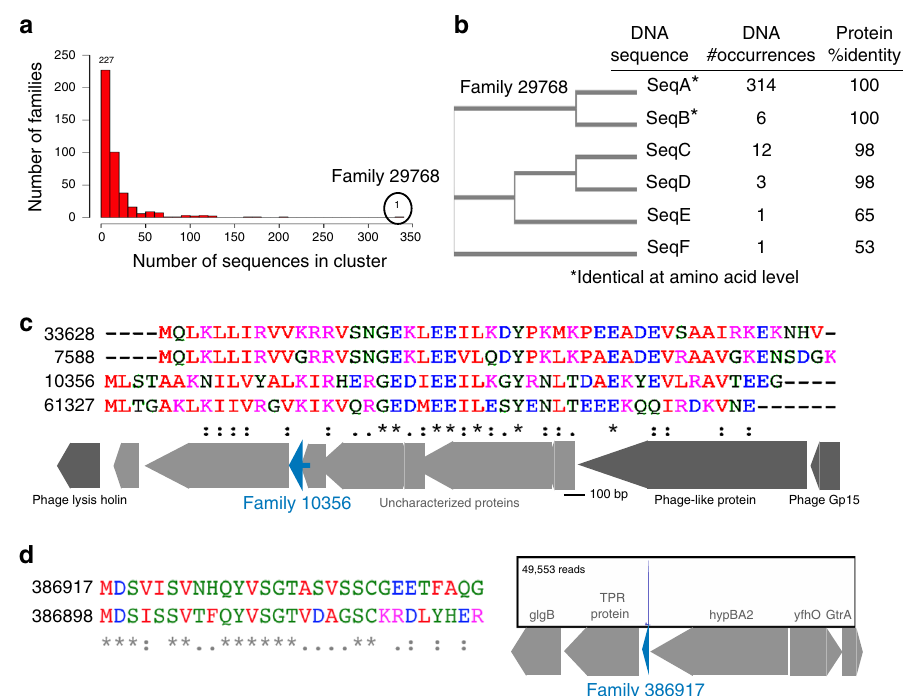
Fig. 6 Characterization of small protein families predicted using MetaRibo-Seq. a Histogram depicting the number of sequences representing each of the small protein families in the 420 set. b Cladogram representing the six unique DNA sequences that comprise family 29768, the family with the most homologs within the 420 set. We show the number of occurrence of each DNA sequence found within the family. We additionally show the amino acid percent identity, relative to SeqA, of the proteins encoded for by these sequences. c Multiple sequence alignment of four homologous small protein families 33628, 7588, 10356, and 61327 from the 420 set. Only representative protein sequences for each of these protein families are shown in the alignment. These four small protein families are often found near phage genes, as we depict using an example of the genomic neighborhood of family 10356. This speci fi c genomic neighborhood is found in Hungatella hathewayi with the small protein (Genebank: CUP46342) represented as a blue arrow. d Multiple sequence alignment of two small protein families (386917 and 386898) within the 2,091 set (but not the 420 set), representing the most highly translated small proteins in our data. IGV visualization (Sashimi plot) of one 386917 homolog in sample D is